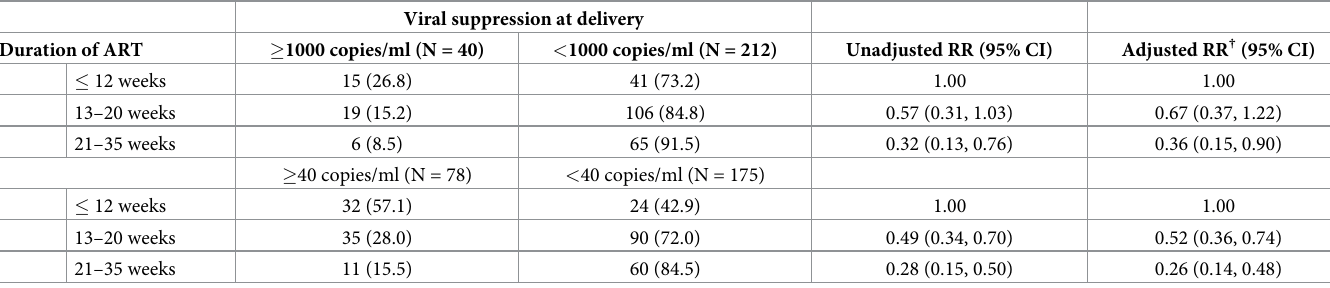
Fig 1. In the primary analysis, women who were on ART for 13–20 weeks (adjusted risk ratio (aRR) = 0.52; 95% CI: 0.36–0.74) or 21–35 weeks (aRR = 0.26; 95% CI: 0.14–0.48) were less likely to have VL (cid:21) 40 copies/ml than women who were on ART for (cid:20) 12 weeks (Table 4). The Table 4. Associations between duration of ART at delivery and viral suppression at